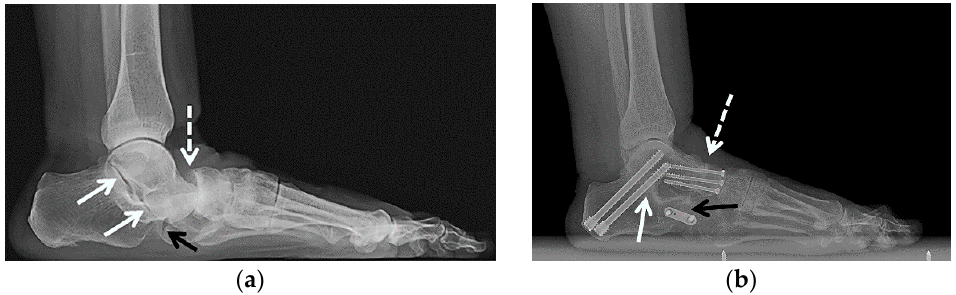
Figure 7. ( a , b ) A 64-year-old female with a history of traumatic right talonavicular dislocation several months prior presented with continued pain, pes planus with plantar valgus and equinus contracture and posttraumatic osteoarthritis, subsequently treated with triple arthrodesis. ( a ) Lat- eral weight-bearing radiograph of the right foot shows per planus with dorsal subluxation of the talonavicular joint and superimposed advanced osteoarthritis (dashed white arrow). Note the as- sociated mild asymmetric narrowing of the subtalar (white arrows) and calcaneocuboid joints (black arrow). ( b ) Postoperative weight-bearing lateral radiograph shows interval triple arthrodesis with two Herbert screws transfixing the posterior subtalar joint (white arrow), three partially threaded cannulated screws transfixing the talonavicular joint (dashed white arrow) and a short plate with two screws transfixing the calcaneocuboid joint (black arrow) with solid bony bridging across the arthrodesis sites.